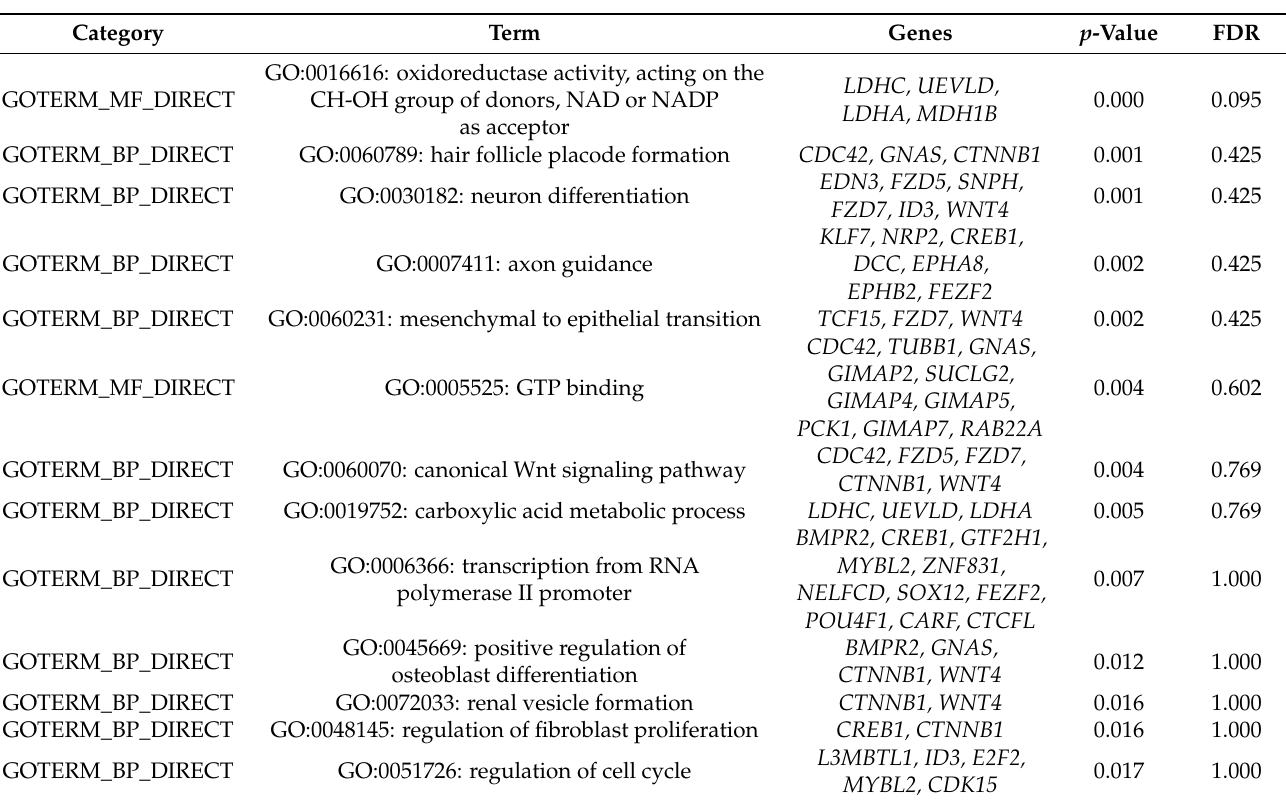
Figure 6. Genome-wide distribution of d i statistic for all 1 Mb windows across all autosomes. The d i values calculated from comparison of BAL population against other Balkan breeds (BAR, IST and RUD) in this study. The dashed gray line indicates the top one percent of total informative windows. Note that on chromosomes 2, 4, 6, 10, 13, 19, 21, and 23 signals exceed the threshold. Table 3. Enriched GO TERMS determined by DAVID from genes identified in selection regions specific to the BAL breed using F ST ( d i ). Please note that GOTERM_MF refers to molecular function and GOTERM_BP refers to biological